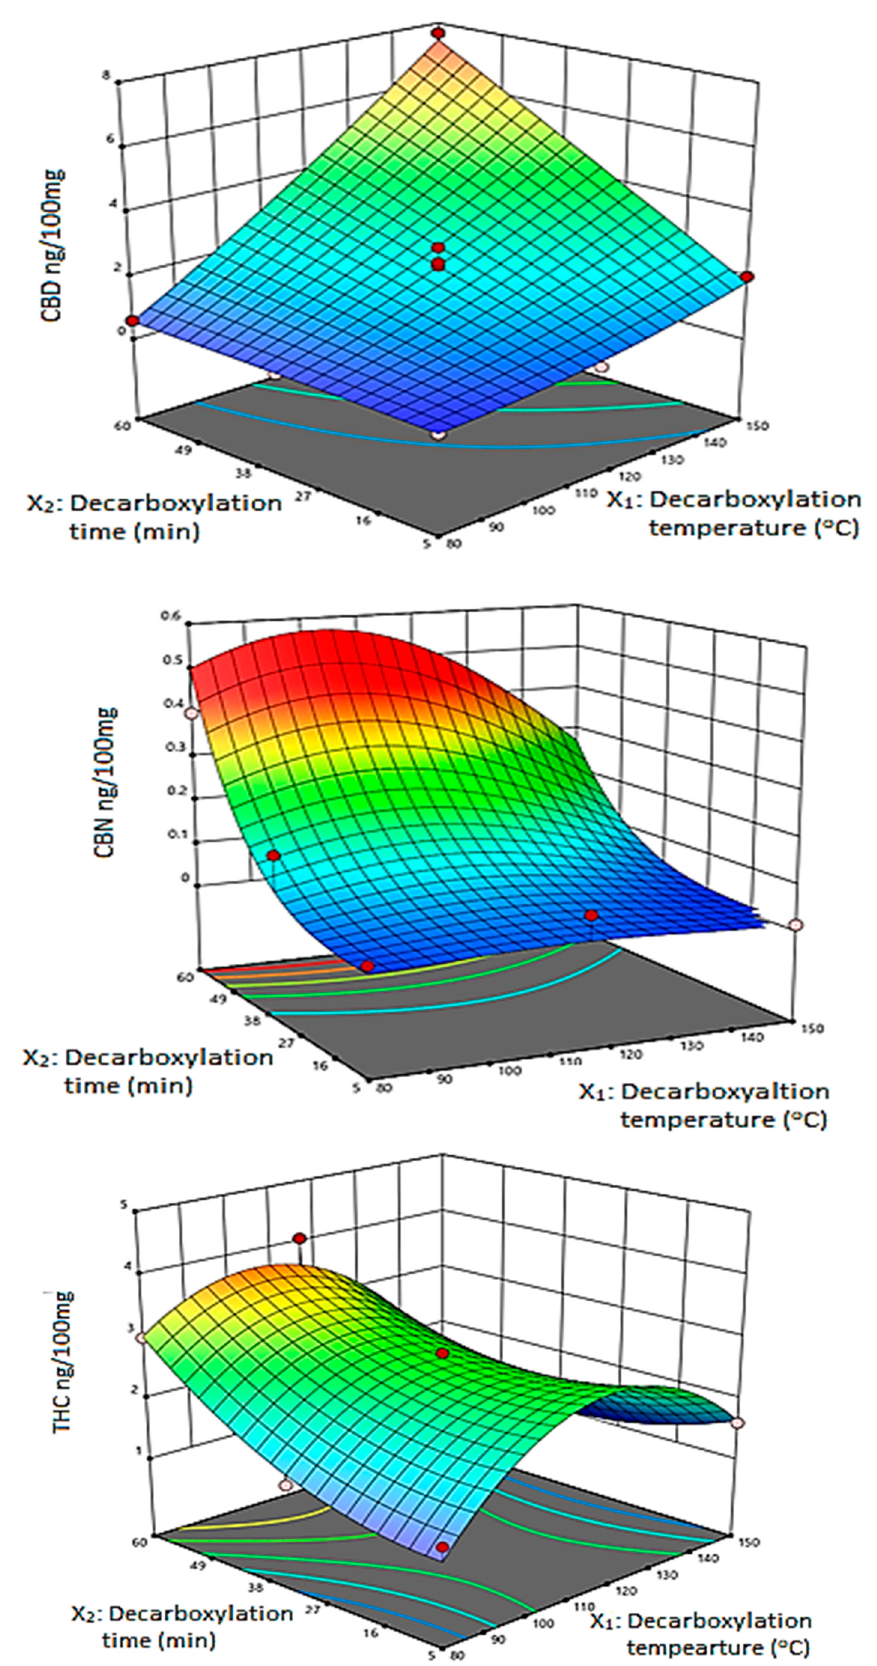
Figure 3. 3D response surface plot.